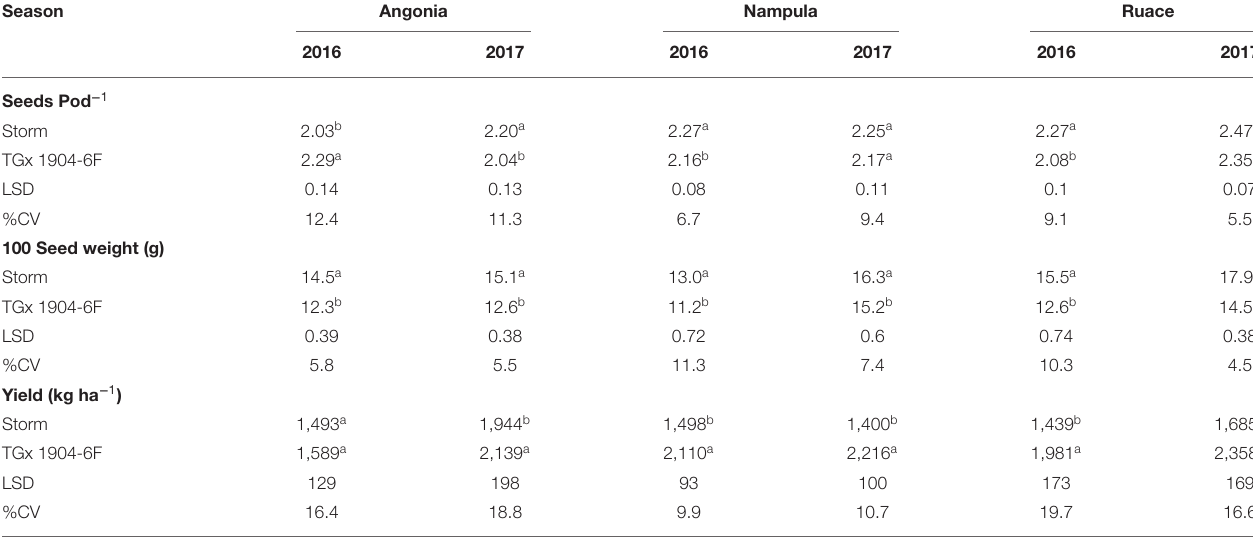
TABLE 8 | Yield components varietal differences of inoculated soybean.